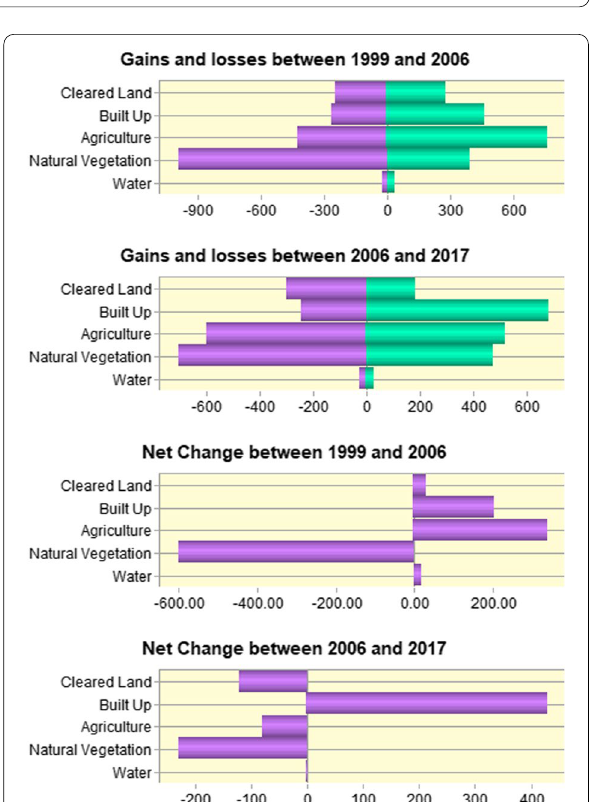
Fig. 4 The gain and losses and net change in km 2 , for each land cover class from the year 1999 to 2006 and from the year 2006 to